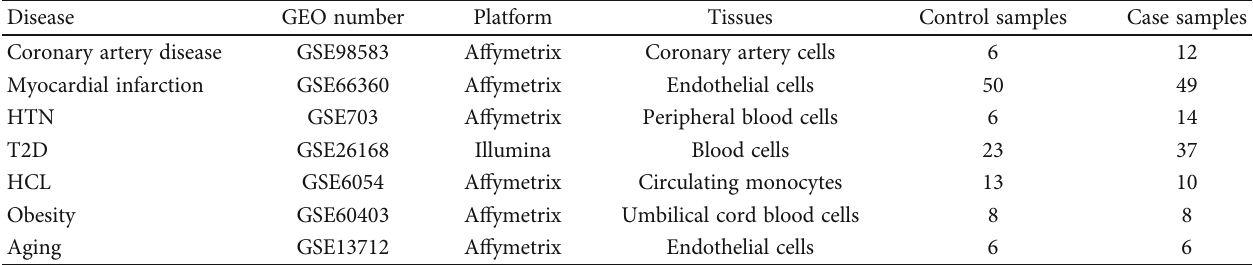
Table 1: Descriptions of selected datasets with GEO accession number, platform, tissues, and number of samples.